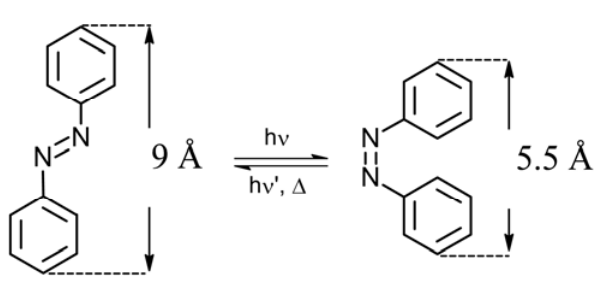
Figure 1. Photo-induced structure change in azobenzene